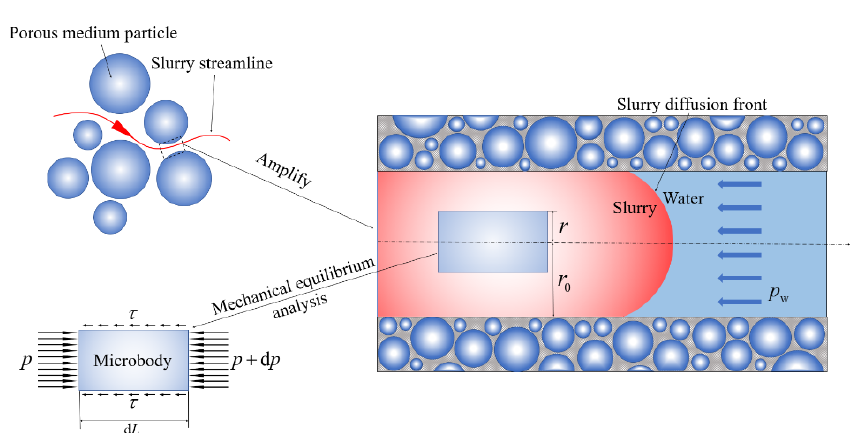
Figure 3. Unit ‐ volume equilibrium analysis of the power ‐ law fluid in the capillary. Figure 3. Unit-volume equilibrium analysis of the power-law fluid in the